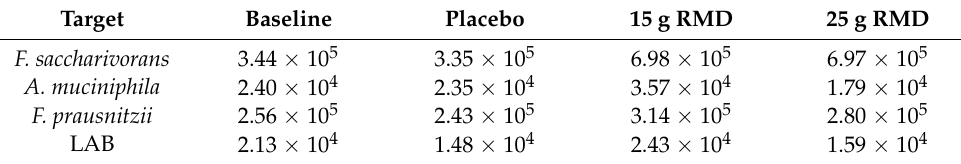
Table 1. qPCR-detected changes in log 10 counts of targeted fecal bacteria.